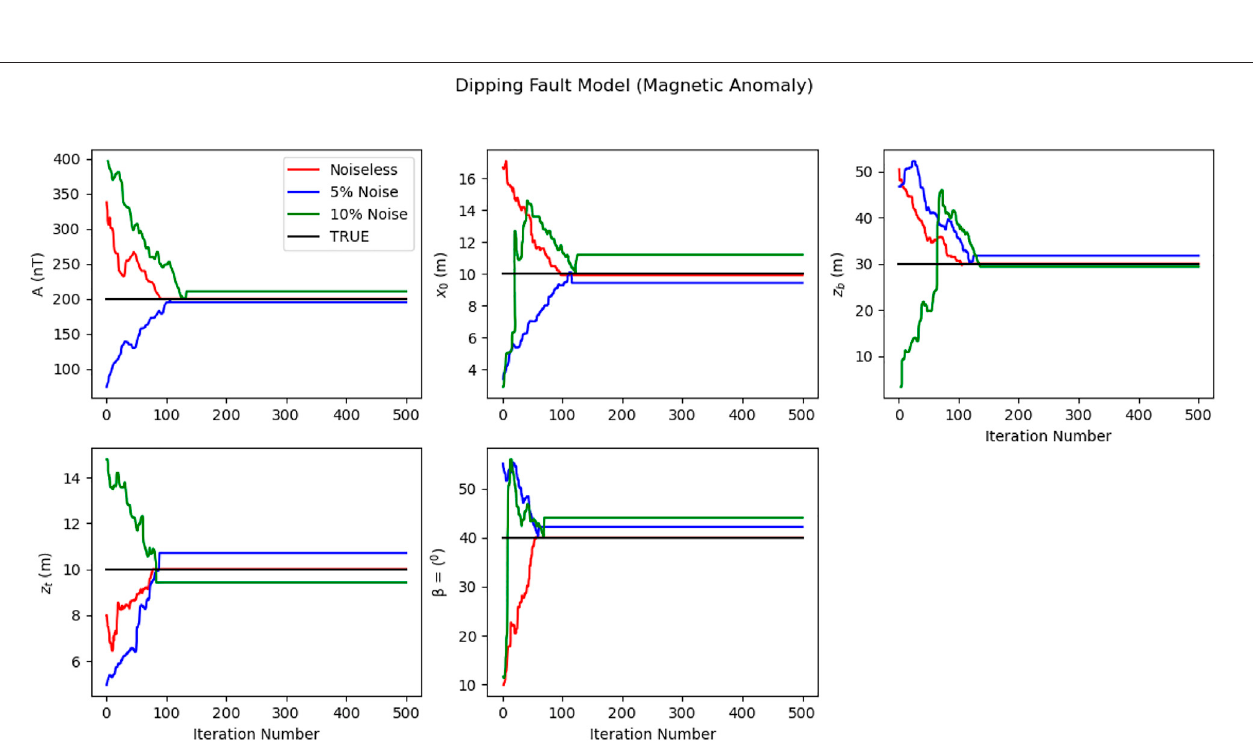
FIGURE 11 | Change in model parameters with iteration (Magnetic Anomaly).